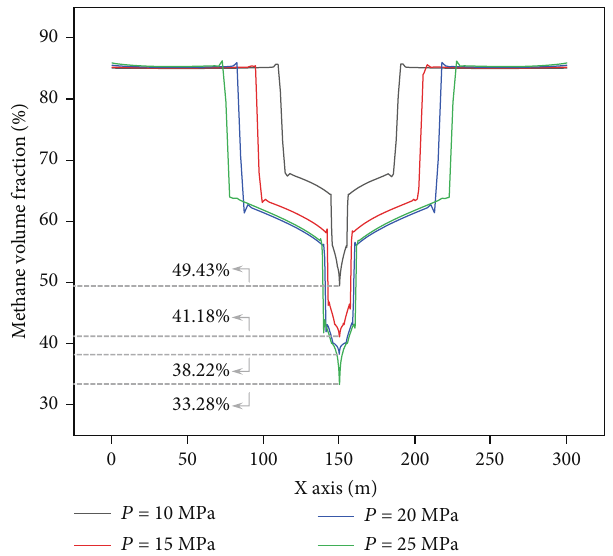
Figure 20: V at the end of air injection (16h) following water injection. CH 4